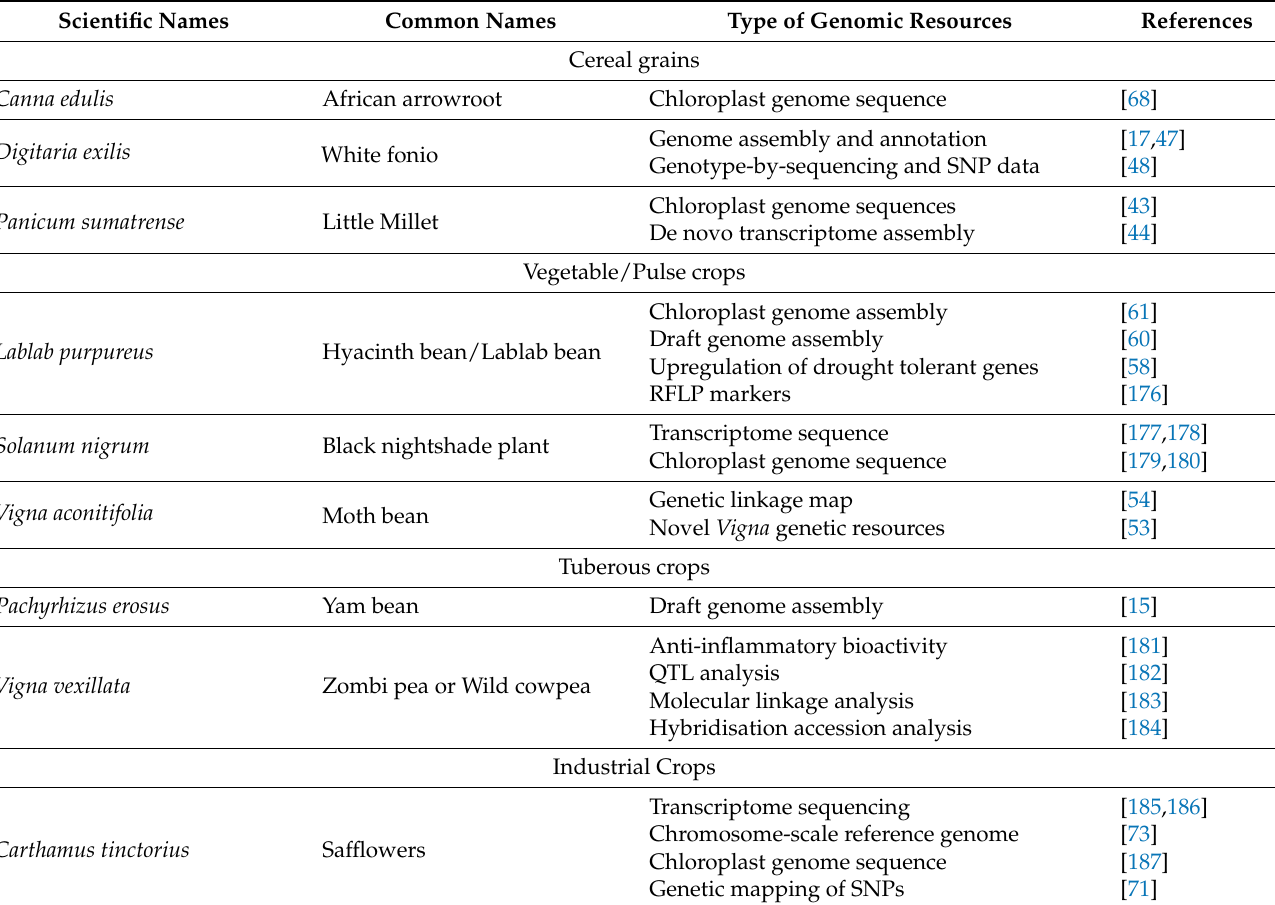
Table 3. Underutilised crops with genetic